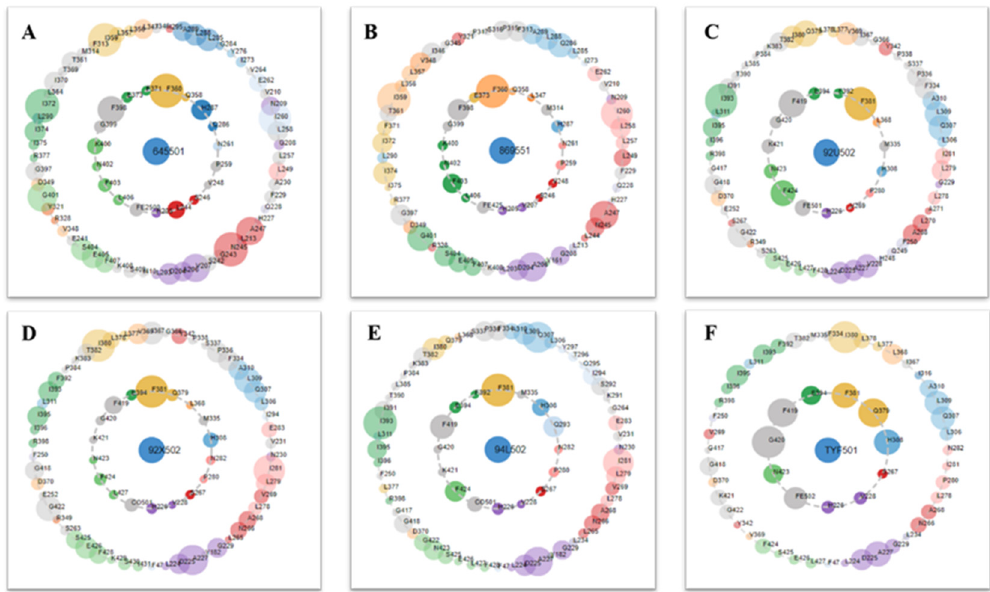
Figure 8. Protein–ligand contacts are represented by asteroid plot. The asteroid plot of At HPPD co-crystal structure RCSB PDB database (PDB) code: ( A ) 1TG5, ( B ) 1TFZ, ( C ) 5YWH, ( D ) 5YWK, ( E ) 5YY6 and ( F ) 5XGK). Co-crystal ligand in the center is denoted as blue node. The residues in the inner and outer circle represent directly and indirectly contacting residues, respectively. Size of the circle indicates the number of atomic contacts and the residues are colored according to their secondary structures.